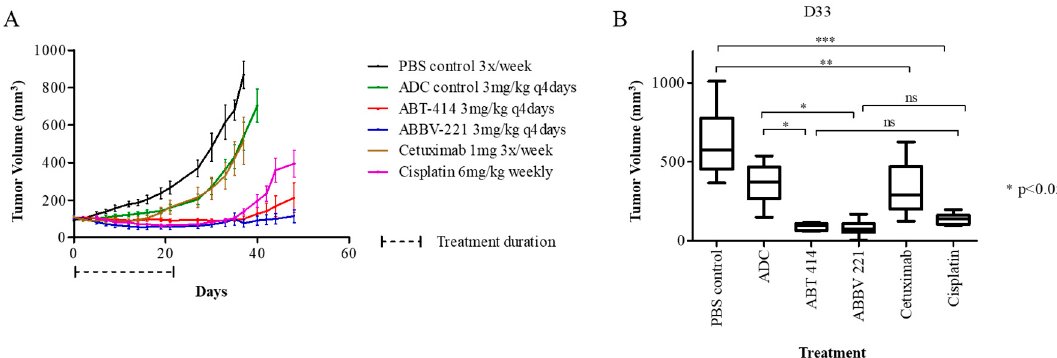
Figure 3. Antitumor activity of ABT-414 and ABBV-221 against the MSTO-211H xenograft model. ( A ) Tumor growth curves of mice ( n = 10) in each group treated at the doses indicated. Significant antitumor responses to both ABT-414 (red line) and ABBV-221 (blue line) were demonstrated and superior to cisplatin (purple line). ( B ) Average tumor volumes 33 days after various treatments were initiated. There was significant tumor growth suppression in the ABT-414 and ABBV-221 treatment groups on day 33 post-therapy compared to the ADC-MMAF control group and cisplatin group. *** p < 0.001, ** p < 0.01 and * p < 0.05; ns: